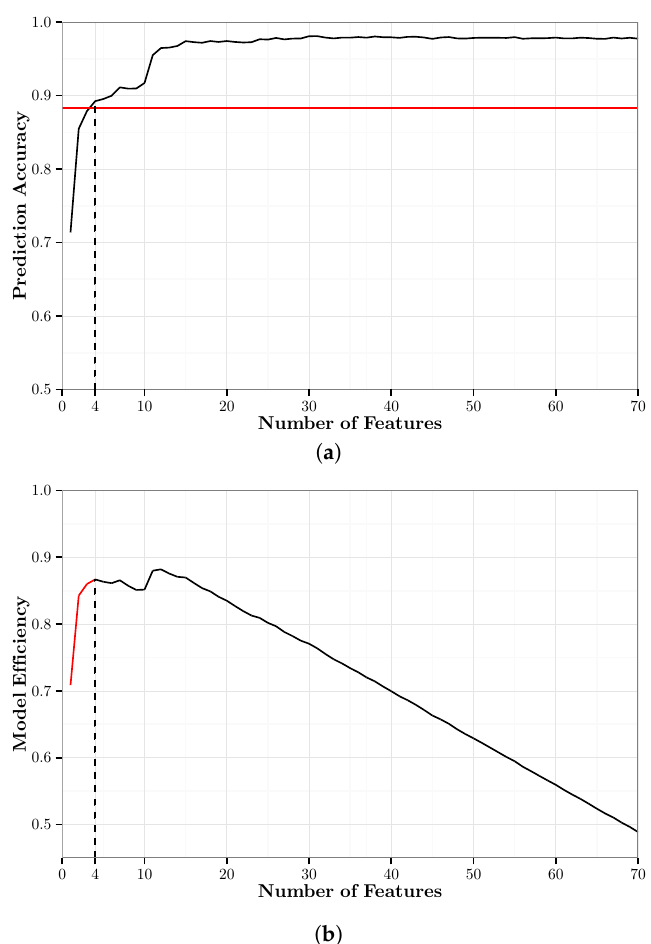
Figure 9. A graphical summary of the RFE-RF models. ( a ) Ten-fold cross-validation accuracy of the RFE-RF models. The solid black line represents the prediction accuracy; the solid red line represents the minimum cut-off accuracy for the optimal model; and the dashed black line represents the minimum number of principal components necessary to attain the cut-off accuracy. ( b ) Model efficiency metric of the RFE-RF models. The red portion represents models that do not meet the cut-off accuracy; the black portion represents models that do meet the cut-off accuracy.